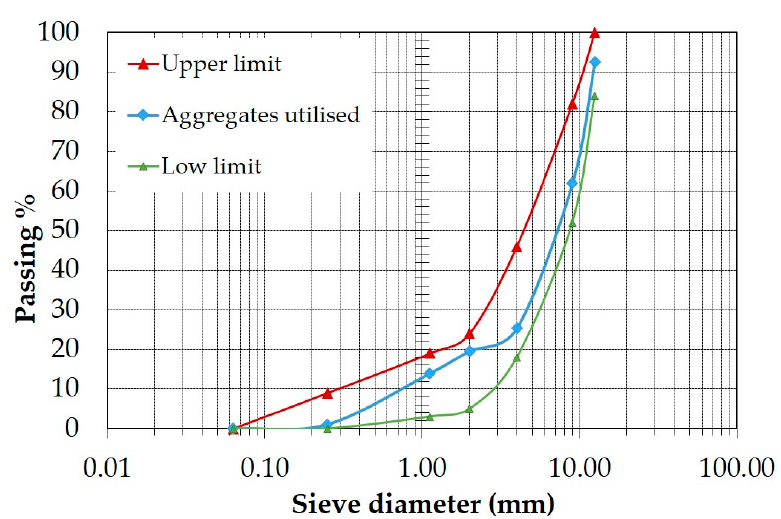
Figure 2. Aggregate gradation for the CR-modified mixture.